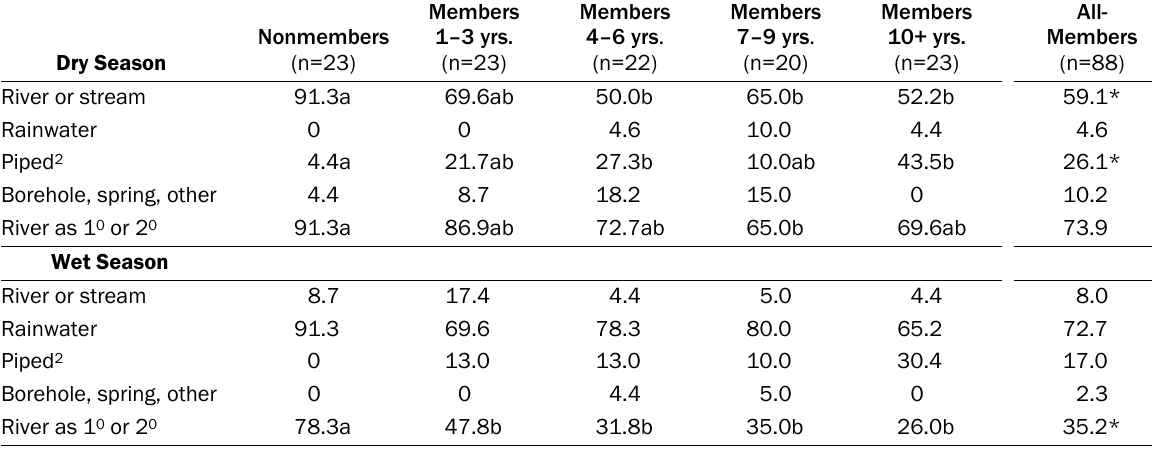
Table 3. Primary Water Source in the Dry and Wet season, by Dairy Group Membership Duration (% of households) 1